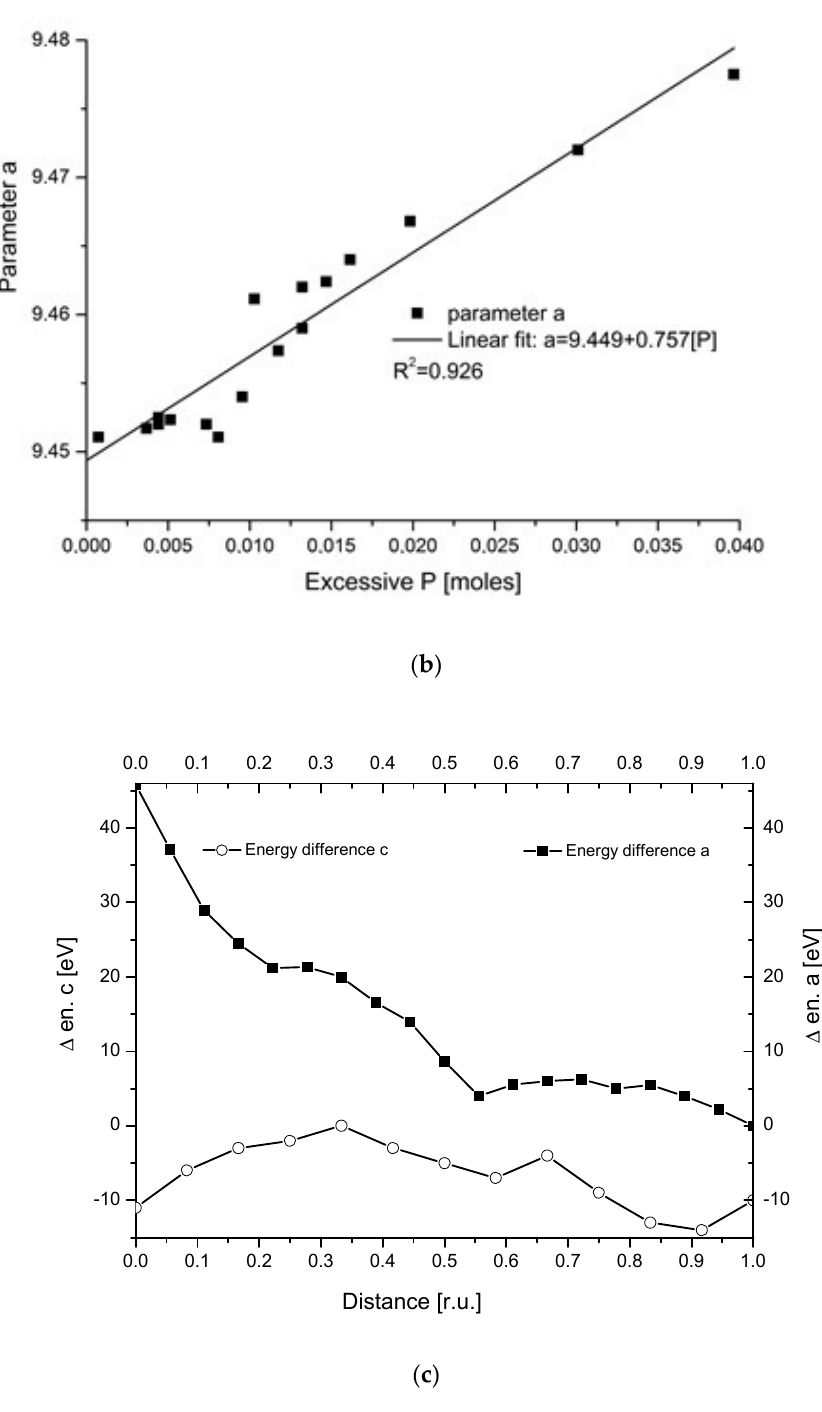
Figure 8. ( a ) Profile of variability of crystallographic parameter “a” (black line with open squares) with its exponential approximation (solid line) as compared with profile of P (black line with solid squares); ( b ) correlation between parameter “a” and excessive P contents; ( c ) changes in energy of transformation in plane (001) and perpendicularly to it. The same can be repeated for line (002), with coefficients 12.4 in Equations (Ib) and (Ic), and the c parameter instead of the a one. This time, the energetic difference between initial and final states as taken from Al-Jawad et al. [69] is minimal, ~1 eV, but intermediate